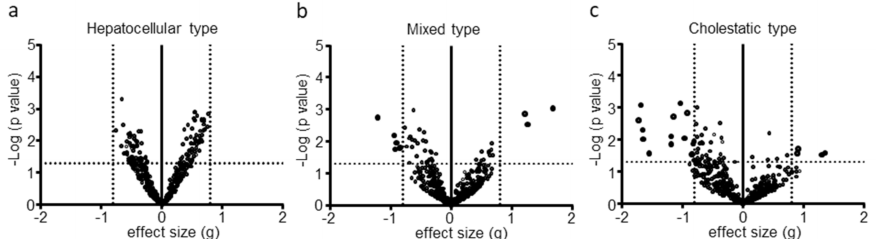
Figure 1. Volcano plot of lipid alterations in three types of DILI. Statistical probability ( p value) and e ff ect size (g) were determined by a comparison of lipid levels between acute phase and recovery phase of the DILI patients. Volcano plots show -log p value versus g value for ( a ) hepatocellular type, ( b ) mixed type, and ( c ) cholestatic type. Each dot represents an individual